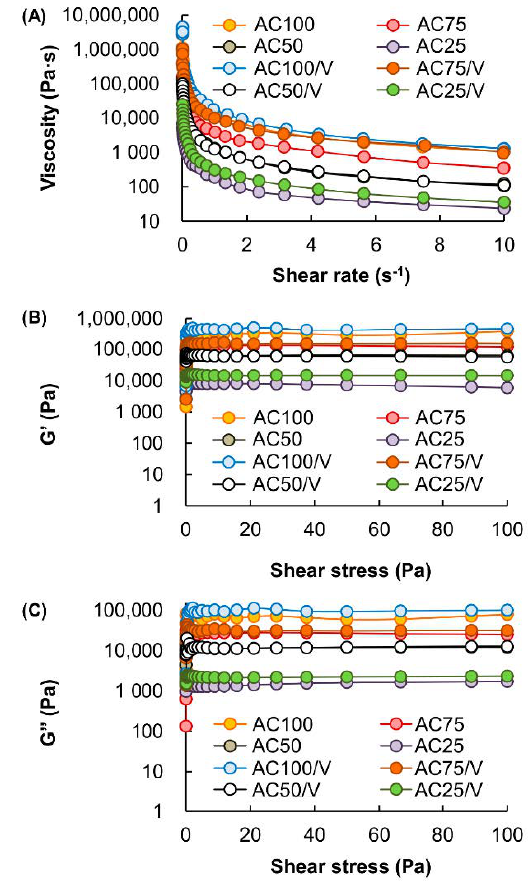
Figure 6. ( A ) Changes in the viscosity of different complex gels before and after being loaded with the vesicles. ( B ) Changes in the G’ values of different complex gels from 0 to 100 Pa. ( C ) Changes in the G’’ values of different complex gels from 0 to 100 Pa.